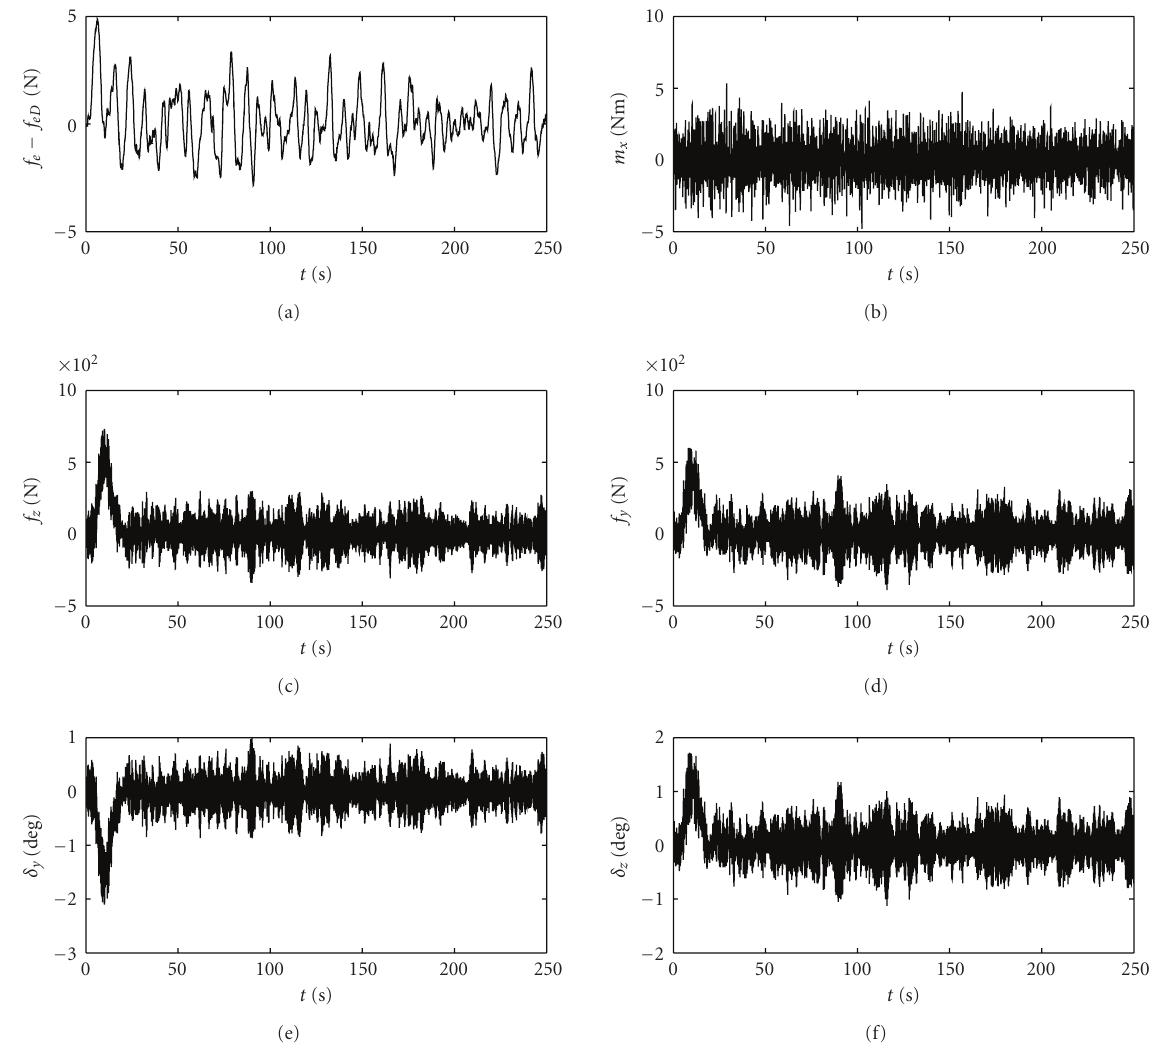
Figure 5: Response to initial conditions. Column 1: error Control Forces F x (N), F y (N), F z (N), and m x (Nm) versus time (sec). Column 2: error commands f e (N), δ y (deg), δ z (deg) and m x (Nm) versus time as